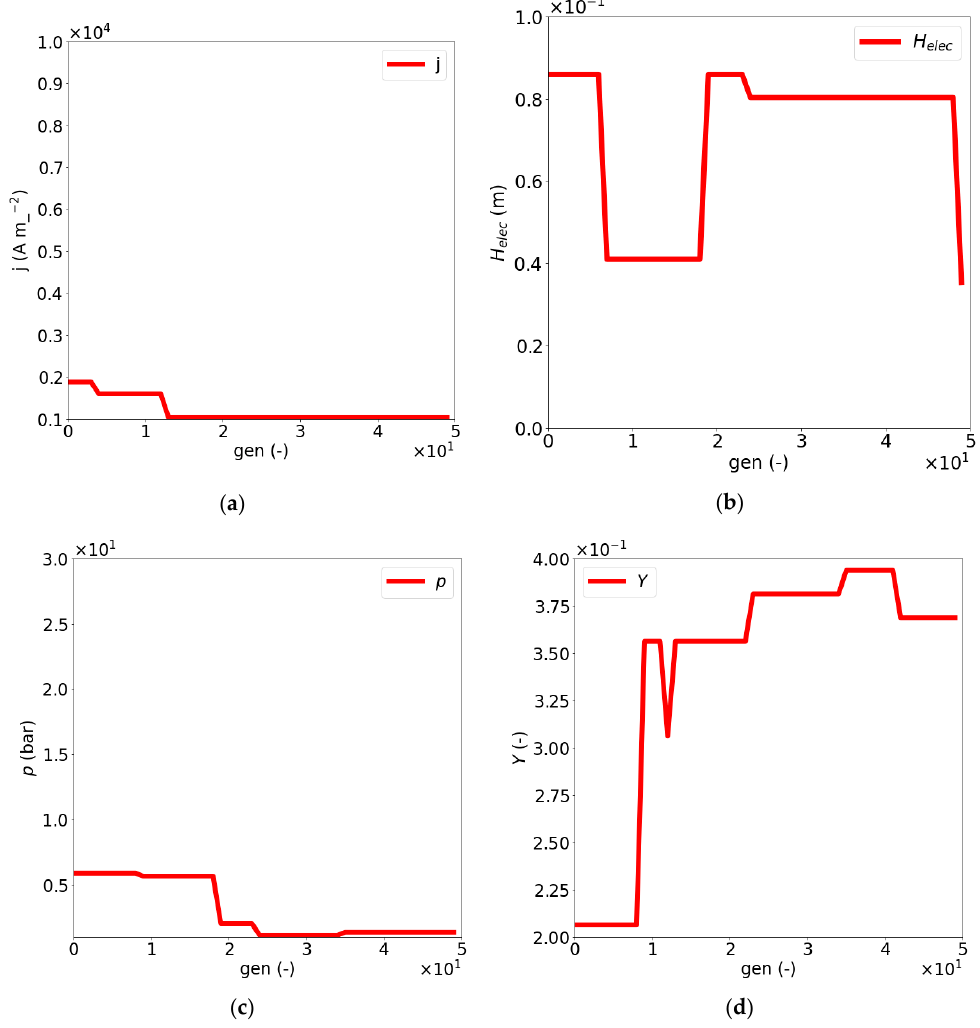
Figure 12. Design parameters evolution for the best 𝐷𝑃 set (in full 𝐷𝑃 space and for a single evolution)